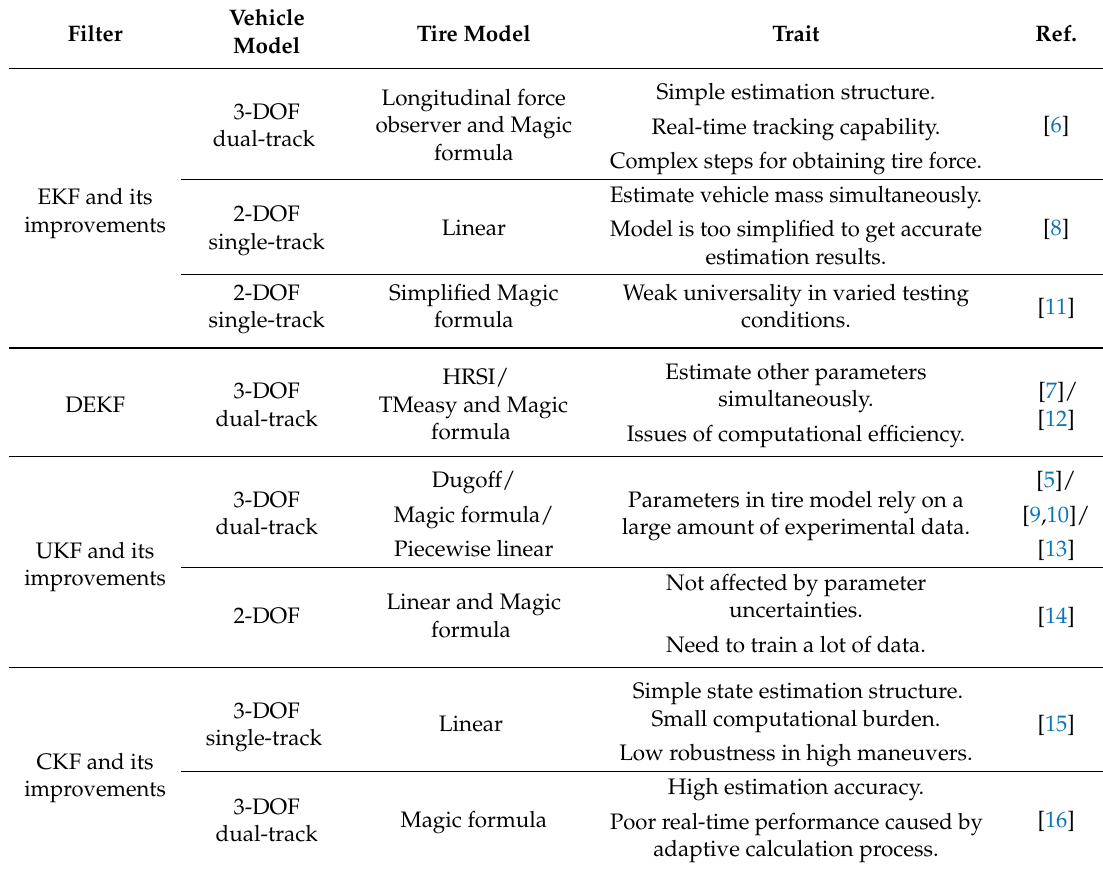
Table 1. Overview of the strategies for vehicle state